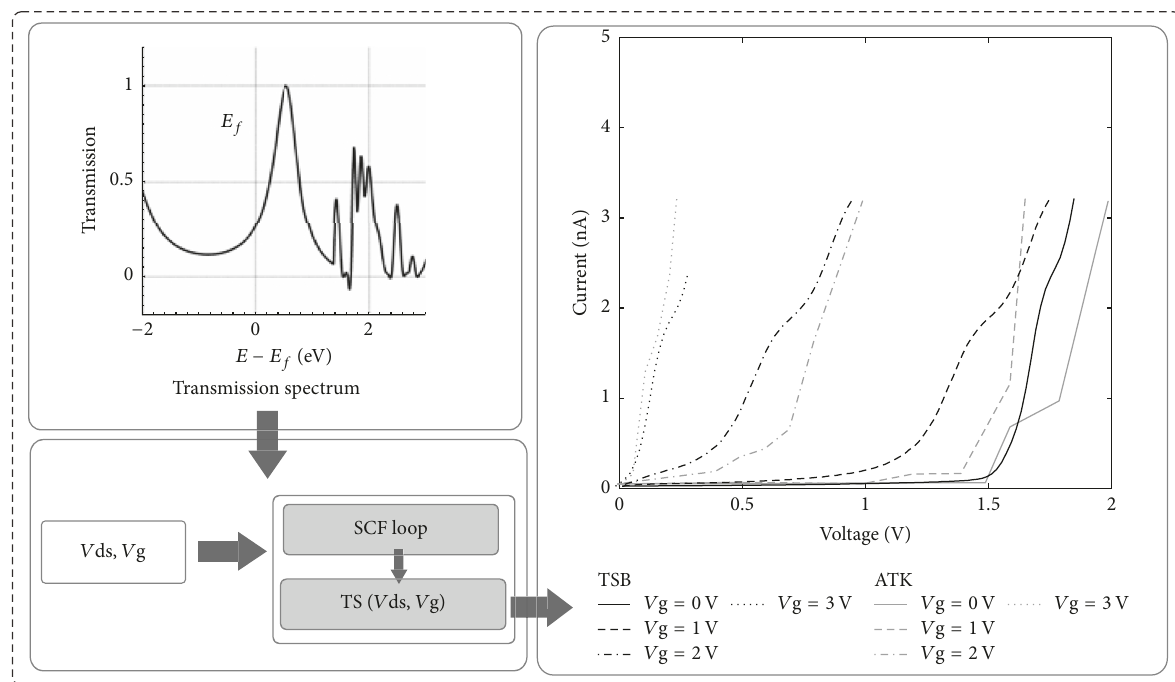
Figure 7: Transmission spectrum based (TSB) model: based on a set of equations to compute the quantum transport inside the molecule. The transmissionspectrum(TS)atequilibriumisobtainedfromATKsimulationsandgivenasinputtothemodel.Fornonequilibriumconditions, that is, external voltages applied ( 𝑉 g, 𝑉 ds), self-consistent field calculations are performed to find the TS and then current is calculated using